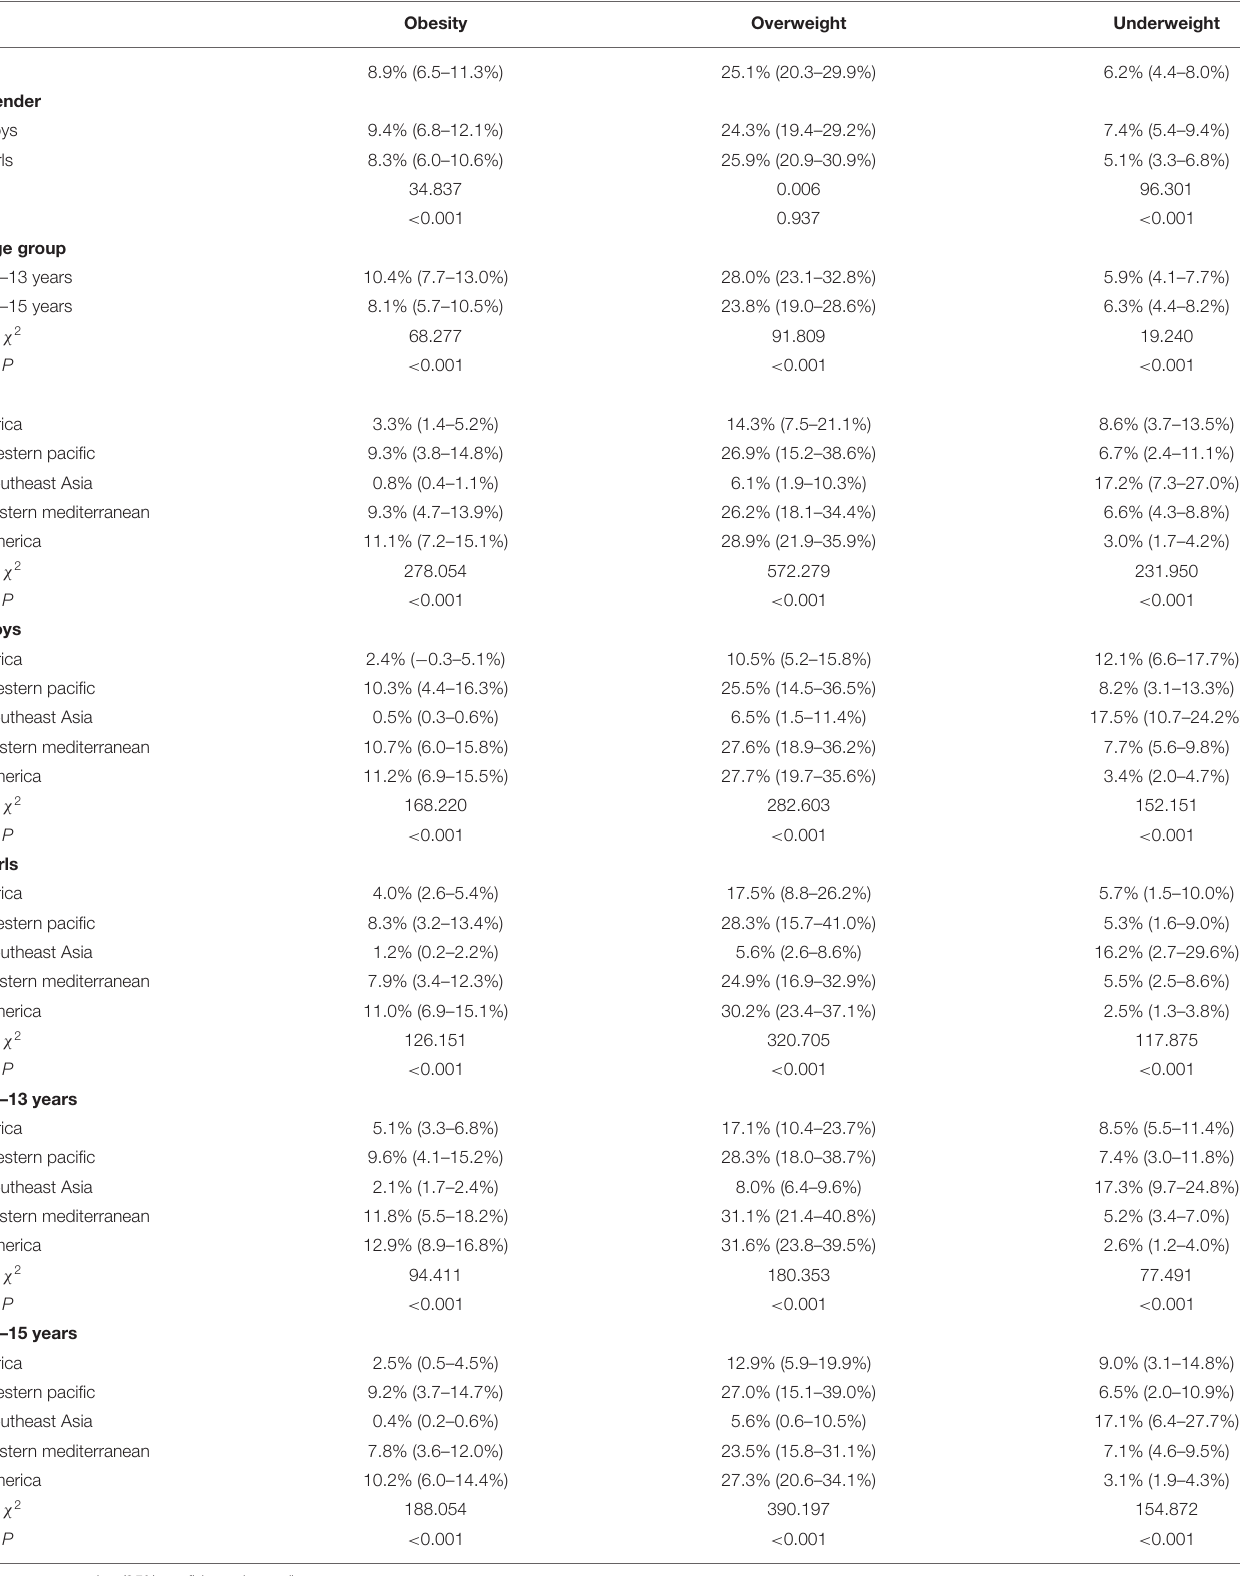
TABLE 2 | Prevalence of obese, overweight and underweight adolescents with hunger by region, sex and age. Obesity Overweight